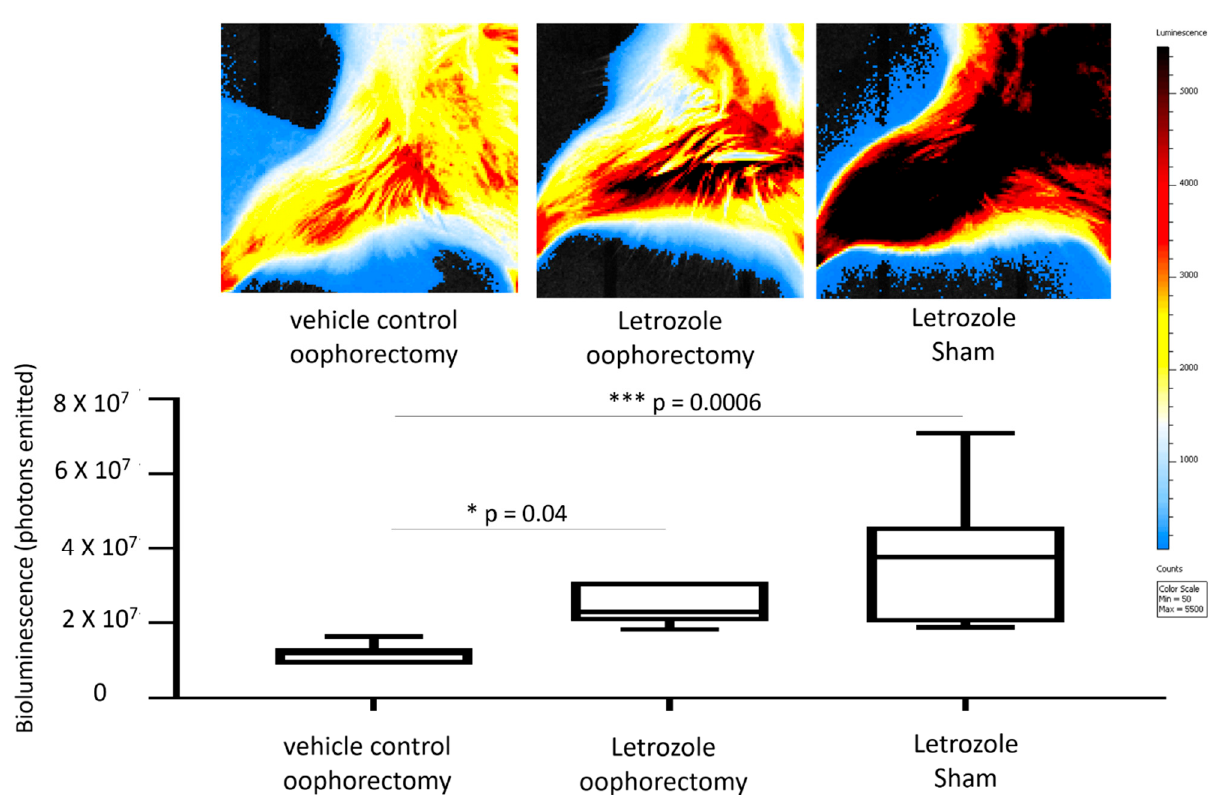
Figure 3. Bioluminescent imaging of NF κ B activity shows aromatase-inhibitor-induced upregulation with and without oophorectomy. Female NFkB-RE-luc mice were treated with letrozole following an oophorectomy procedure. Controls included sham surgery and vehicle control treatment (0.3% hydroxypropylcellulose; HPC). NF κ B activity was measured on the in vivo imaging system (IVIS) approximately at the 5-week timepoint. IVIS (top) and quantitation of bioluminescent signals (bottom) demonstrate induction of NF κ B activity both with and without oophorectomy relative to control mice. Values are the mean ± SEM with indicated p values calculated via one-way ANOVA with Tukey’s corrections for multiple comparisons. * p ≤ 0.05; *** p ≤ 0.001. All values of p ≤ 0.05 were considered statistically significant.